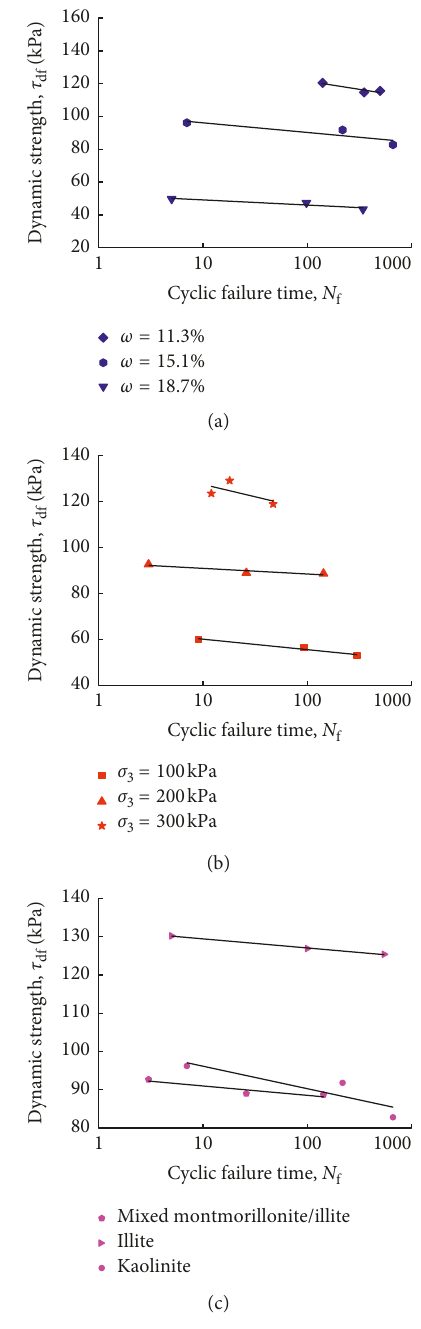
Figure 9: τ df versus N f for different cases of (a) ω , (b) σ 3 , and (c) M